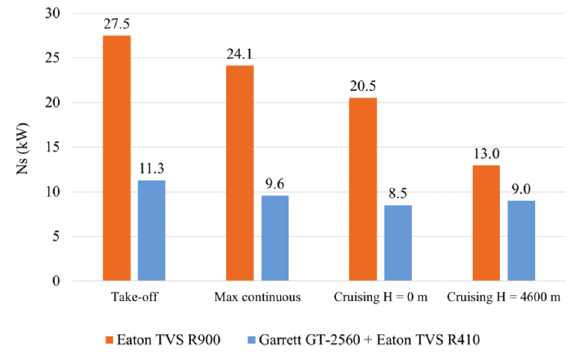
Fig. 5. Comparison of the compressor power for two analyzed variants The value of the average effective pressure for the vari- ant with the turbocharger was lower by 10–12% than for the variant with the mechanical compressor only. However, for both cases, the same power was obtained due to the fact that the turbocharger improved the filling of the cylinder with fresh air. In the case of the variant with the turbo- charger, the increase in altitude did not cause a drop in the effective pressure. A summary of the effective pressure values for the studied cases was shown in Fig. 6.